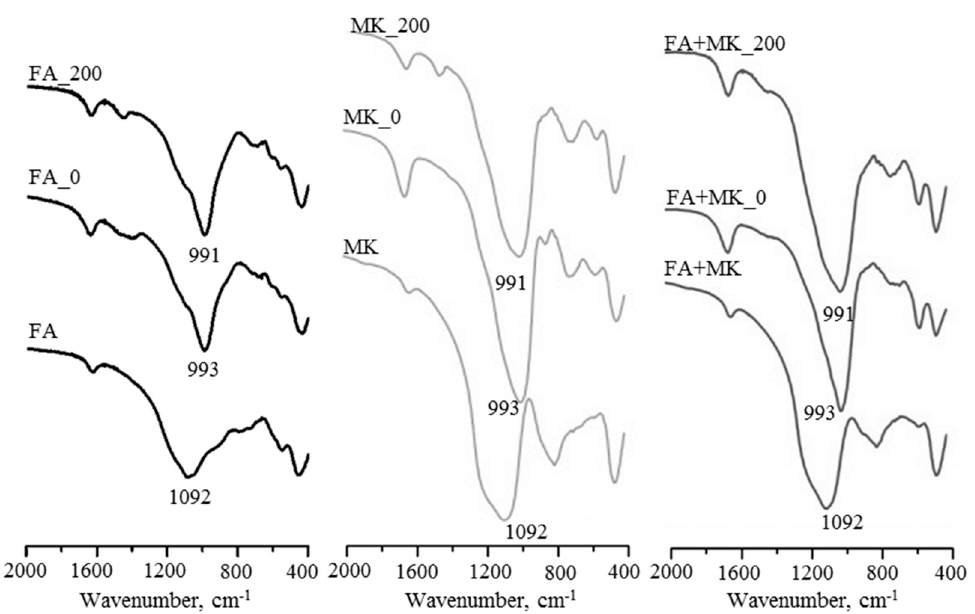
Figure 5. FTIR analyses for solid raw materials and obtained pAAM.